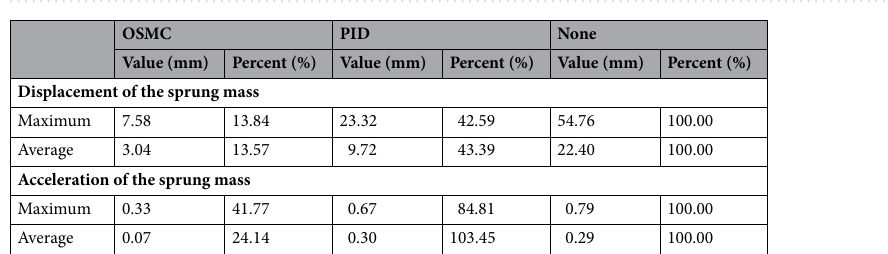
Figure 8. Voltage (( a ) Case 1; ( b ) Case 2; ( c ) Case 3; ( d ) Case 4).